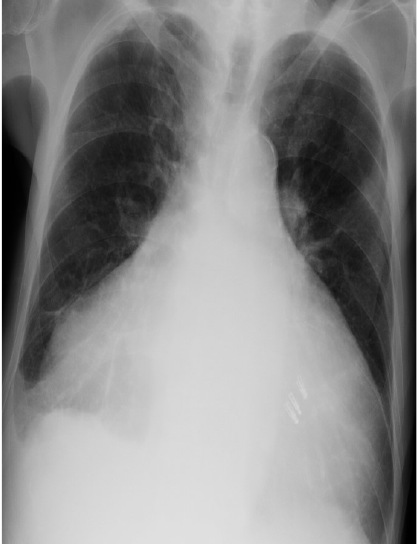
Figure 1. The electrocardiogram showing atrial fibrillation without any ST segmental elevation or depression.